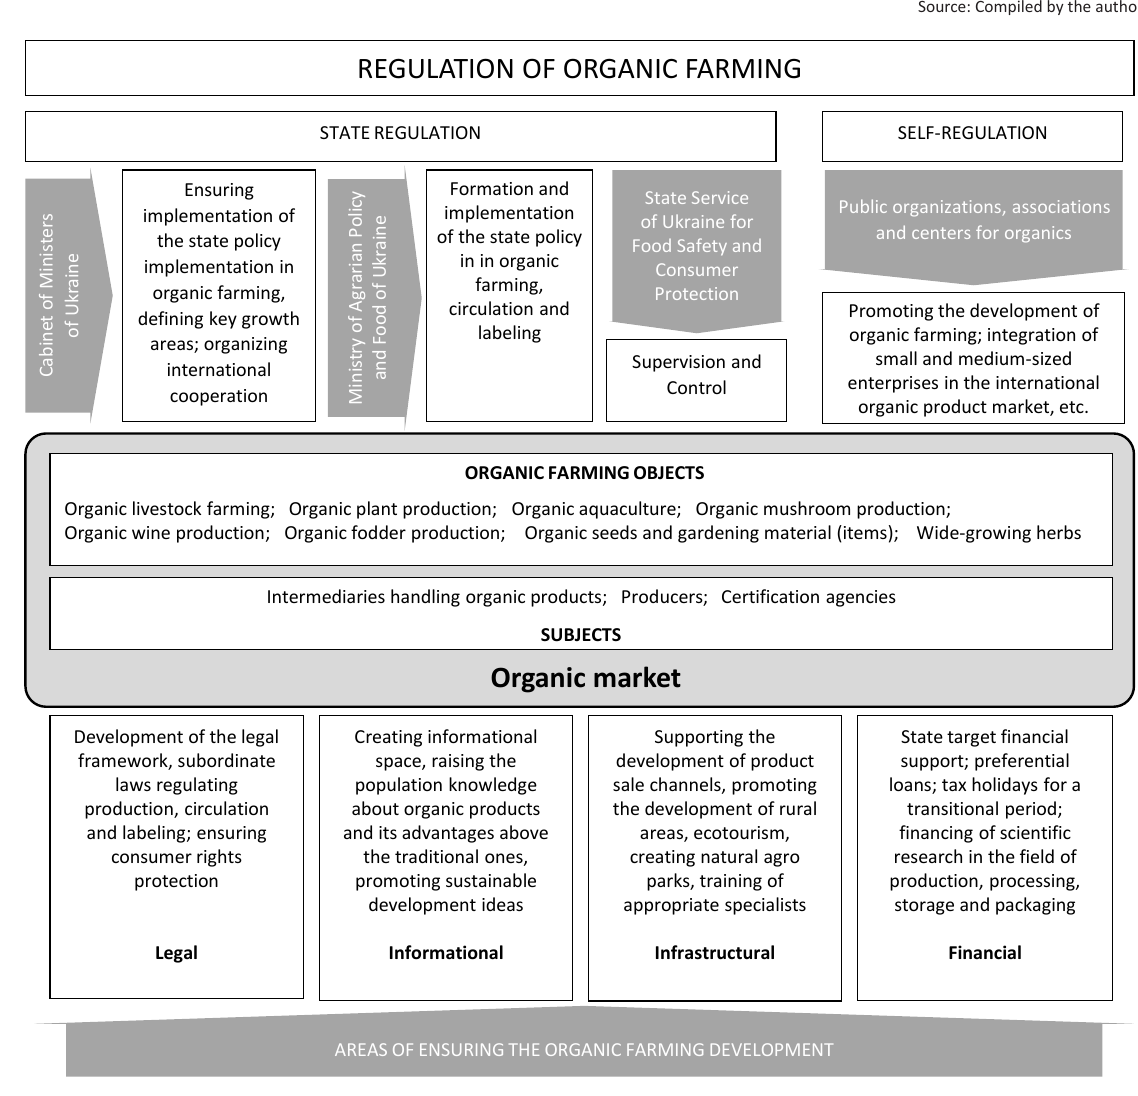
Figure 1. A Conceptual framework of the institutional support for organic farming